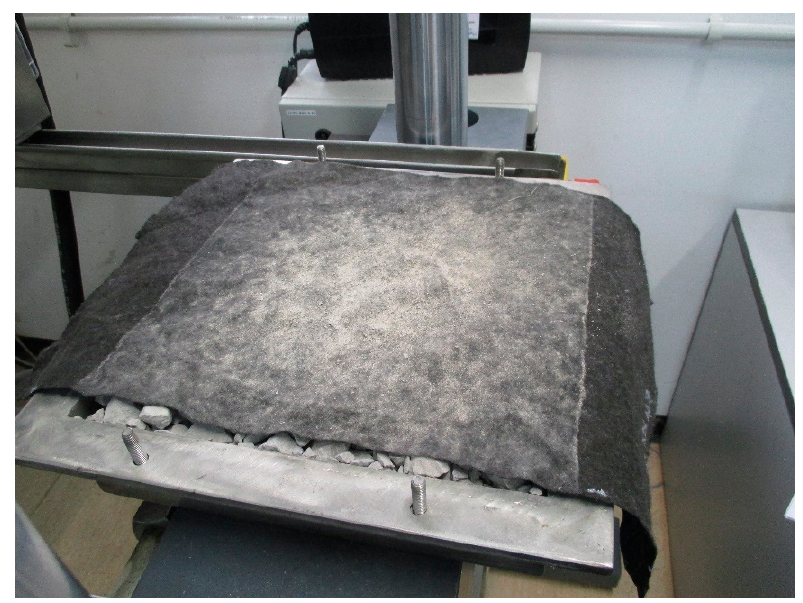
Figure 9. Appearance of the geotextile after a mechanical damage simulation.